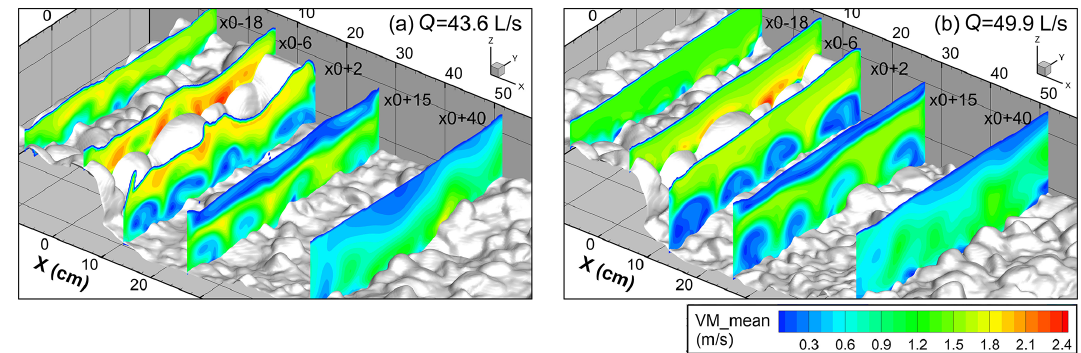
Figure 5. Distribution of time-averaged flow velocity at five cross-sections which are set according to the reference section (x0). The reference cross-section x0 is located at the downstream end of the keystone (KS). The five sections are located at 18 and 6cm upstream of the reference section (x0-18 and x0-6) and 2, 15, and 40cm downstream of the reference section (x0 + 2, x0 + 15, x0 + 40). The spacing for the X , Y , and Z axes is 10cm in the plots.